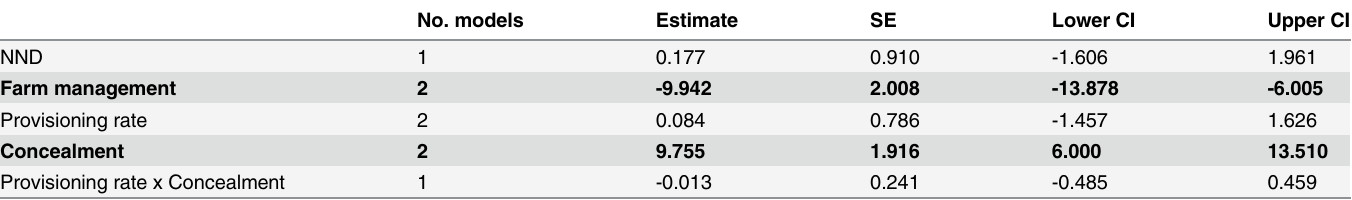
Table 6. Averaged model estimates and 95% confidence intervals from the top models predicting the number of fledglings per successful nest (McFadden ’ s pseudo R 2 =